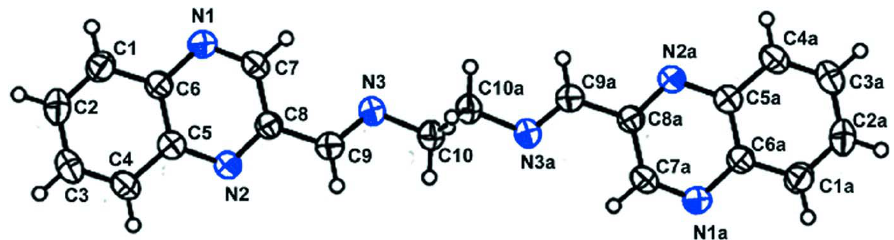
Figure 1 An ORTEP - 3 (Farrugia, 1997) plot of the (I) compound, with the atomic labelling scheme. The shapes of the ellipsoids correspond to 50% probability contours of atomic displacement.